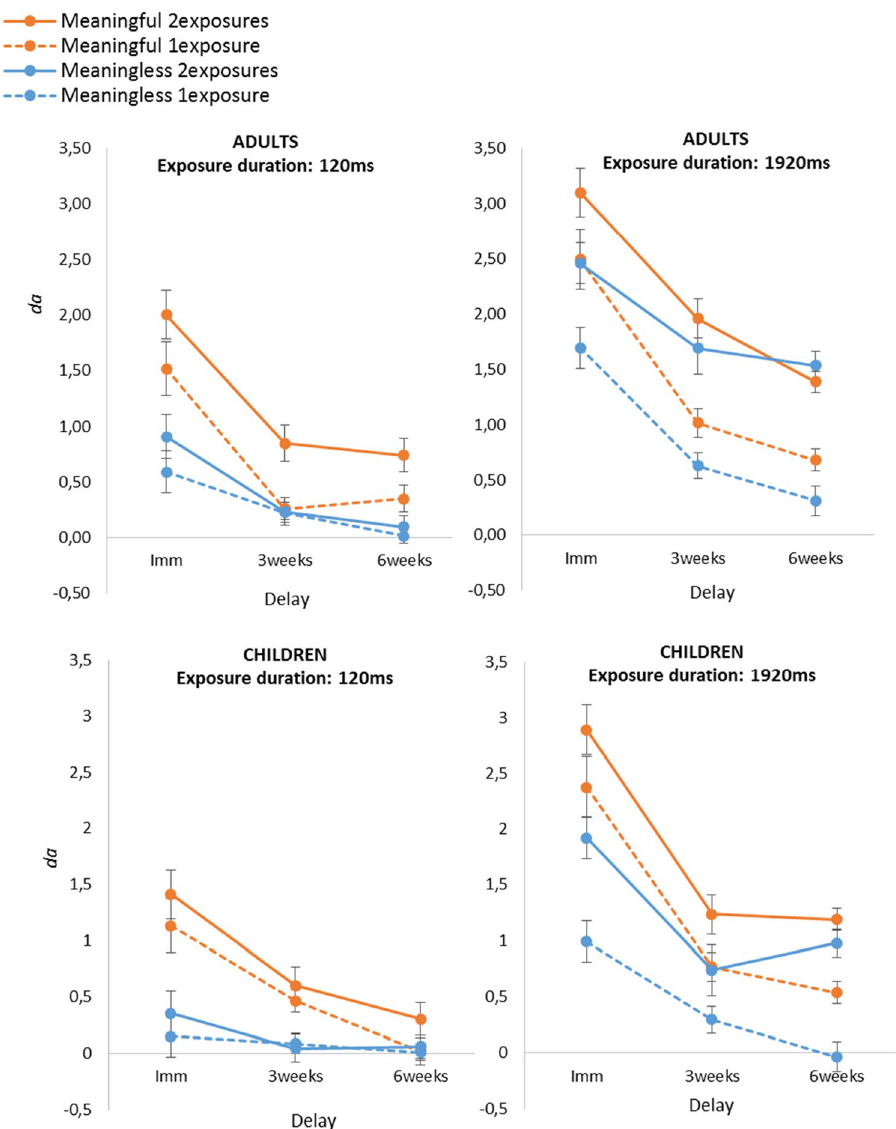
Figure 3. Mean discrimination indexes ( d a ) depending on the delay (immediate, 3-weeks, and 6-weeks), the type of images (meaningful vs. meaningless), the exposure duration (120 ms vs. 1920 ms) and the number of exposures (1 vs. 2). The top panels display the d a observed in adults and the bottom panels display the d a observed in children. The error bars show the standard error of the mean (n =